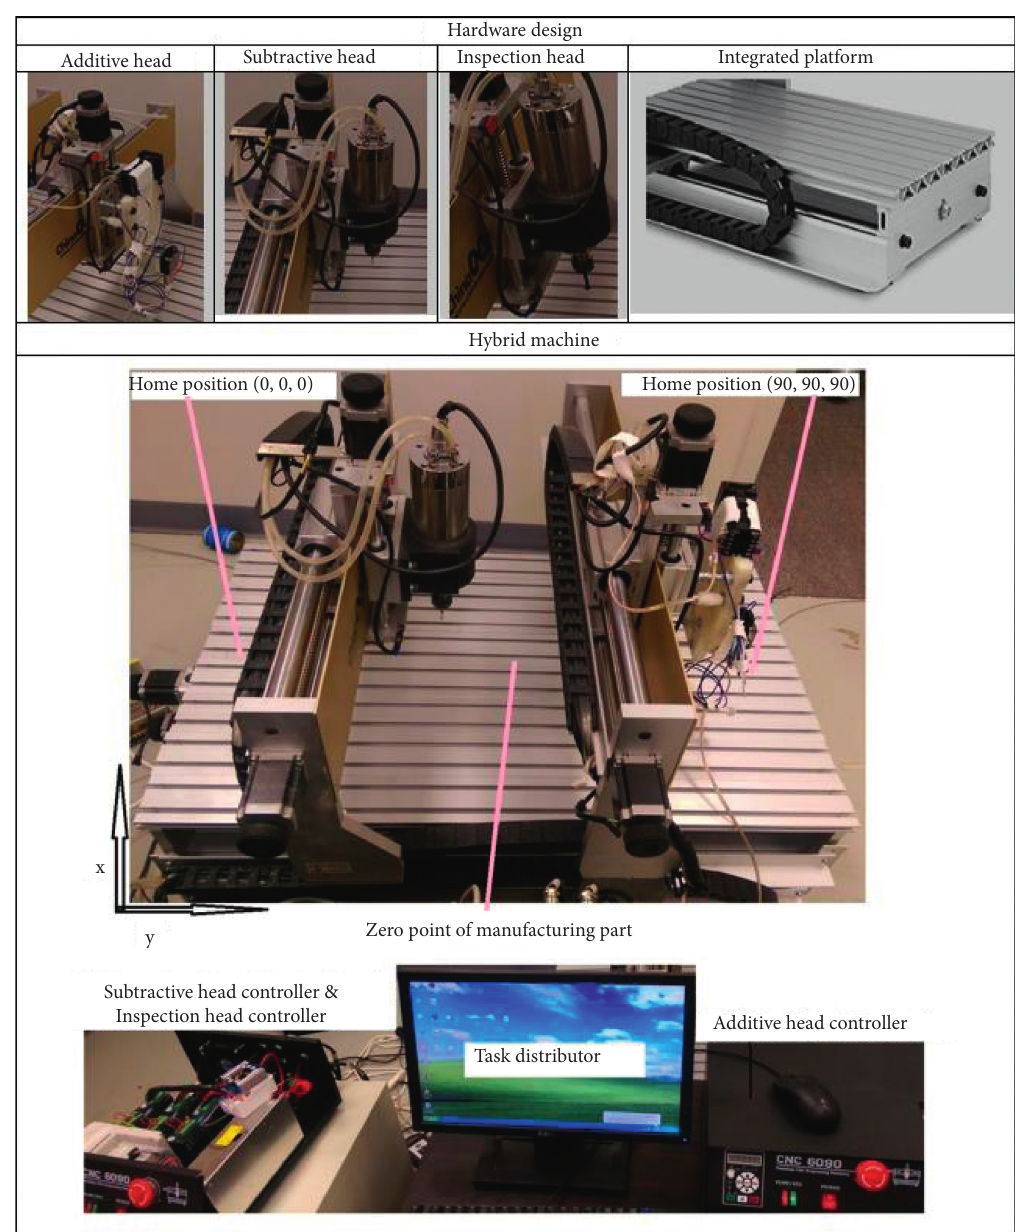
Figure 12: Hybrid additive, subtractive, and inspection machine setup.